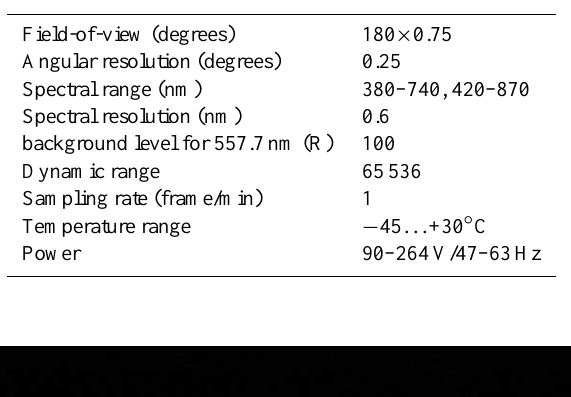
Fig. 2. Optical diagram of the auroral CCD spectral camera S-180.